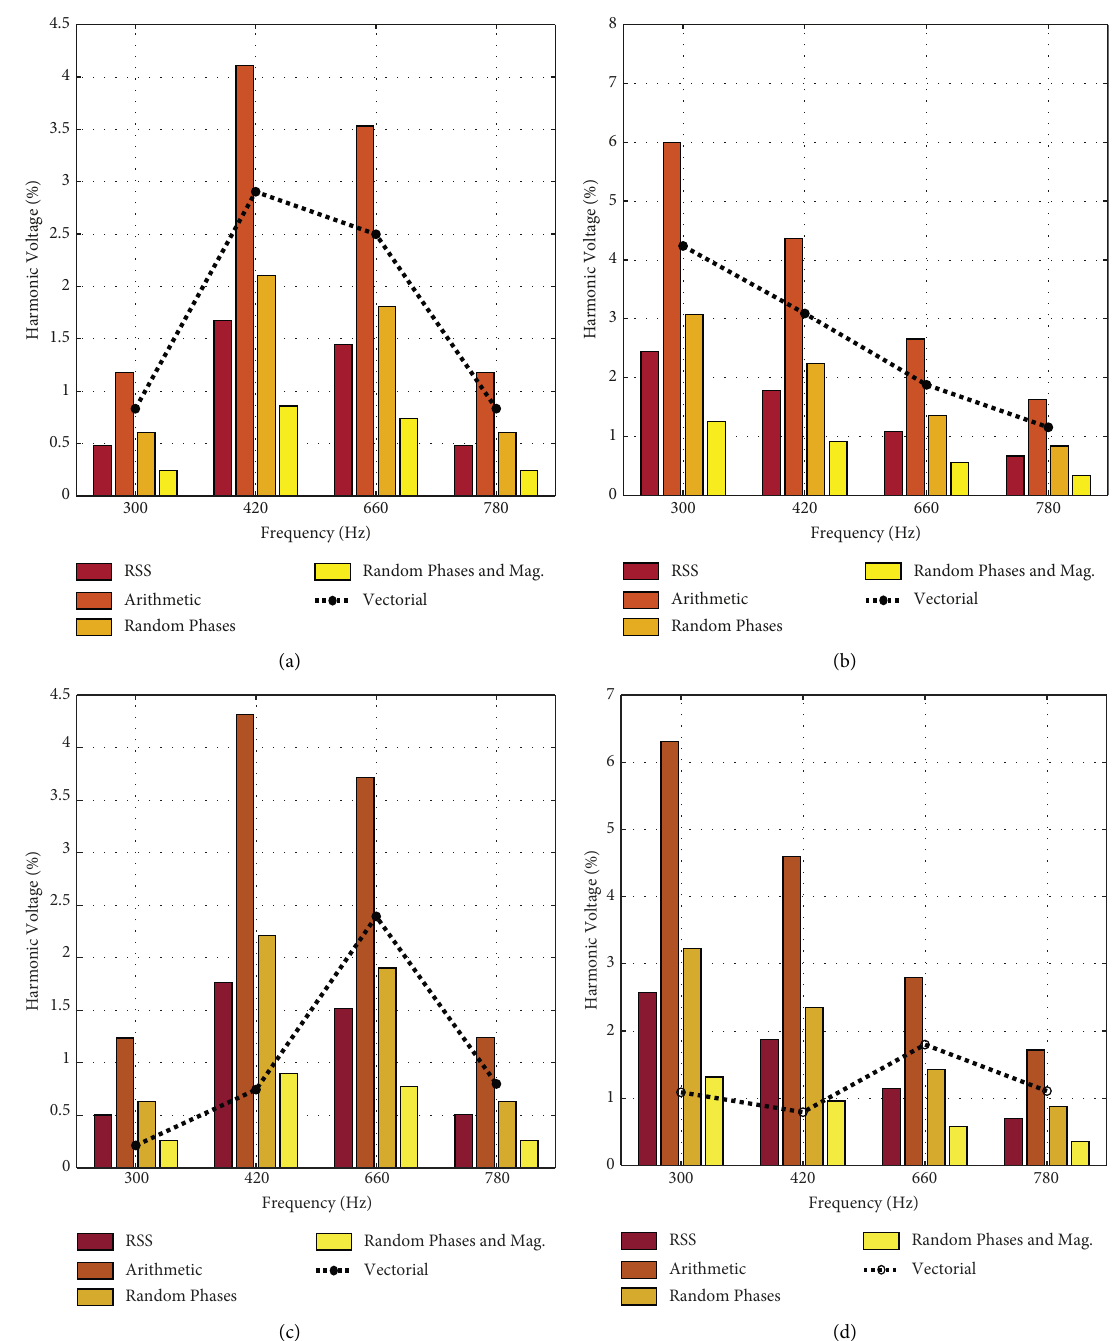
Figure 10: Summation results for Case 1 at busbar 4 (a) and busbar 5 (b), and Case 2 at busbar 4 (c) and busbar 5